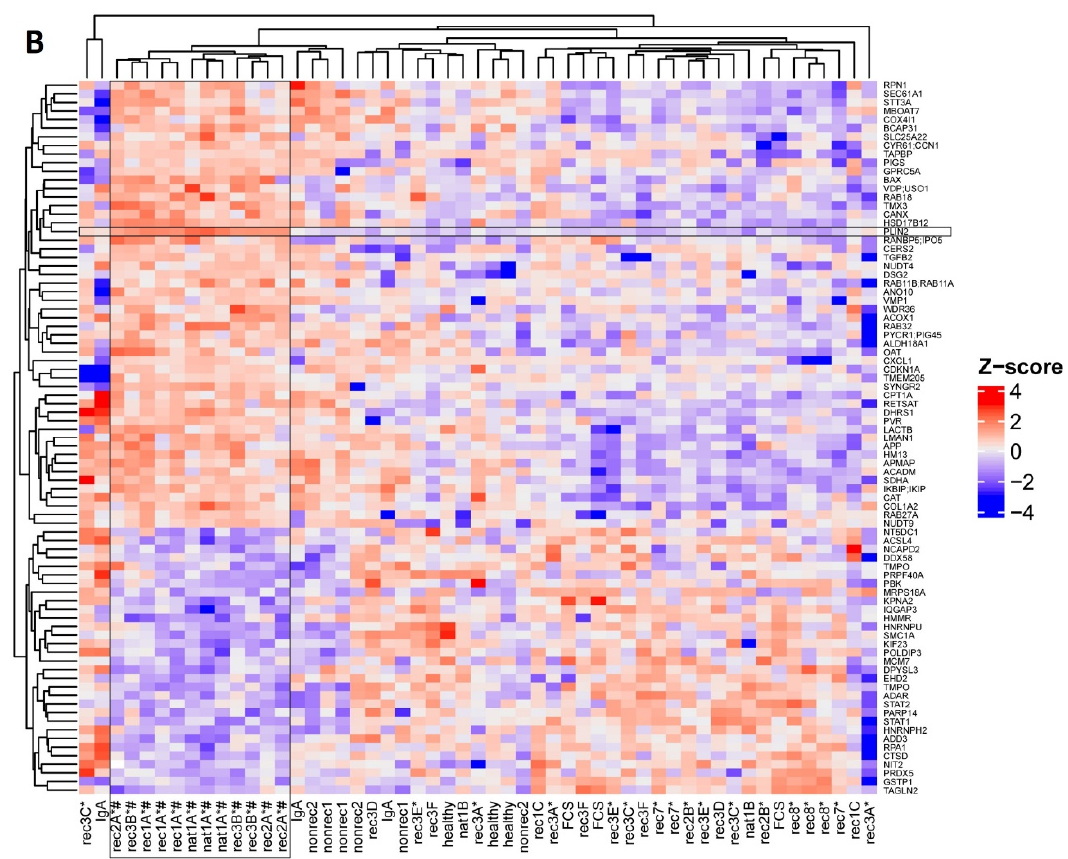
Figure 1. Differentially expressed proteins in hPod exposed to active disease FSGS versus (disease) control plasmas and plasmas inducing high versus low granularity as revealed by proteomics. hPod differentiated in 12-well plates (Corning) were exposed in triplicate to active disease and remission FSGS plasmas, and to (disease) control plasmas. Active disease FSGS plasmas nat1A and rec3B were used in a 7.5% and 5% concentration, respectively, since hPod detached from the plates when using 10% plasma. Protein was harvested and analyzed with LC–MS. ( A ) Heatmap of LFQ intensities of six proteins differentially expressed ( p < 0.10) between hPod exposed to active disease FSGS plasmas and (disease) control plasmas. ( B ) Heatmap of LFQ intensities of 82 proteins differentially expressed ( p < 0.05) between hPod exposed to plasmas inducing high granularity plasmas and plasmas inducing no or low granularity. Z-scores indicate relative protein expression from high (red) to low (blue). *: active disease FSGS plasma; #: plasma inducing high granularity in hPod; FCS: fetal calf serum; healthy: pooled plasma from five healthy donors; IgA: patient with IgA nephropathy; nat: patient with FSGS in the native kidneys; nonrec: patient with non-recurrent FSGS; rec: patient with recurrent FSGS.